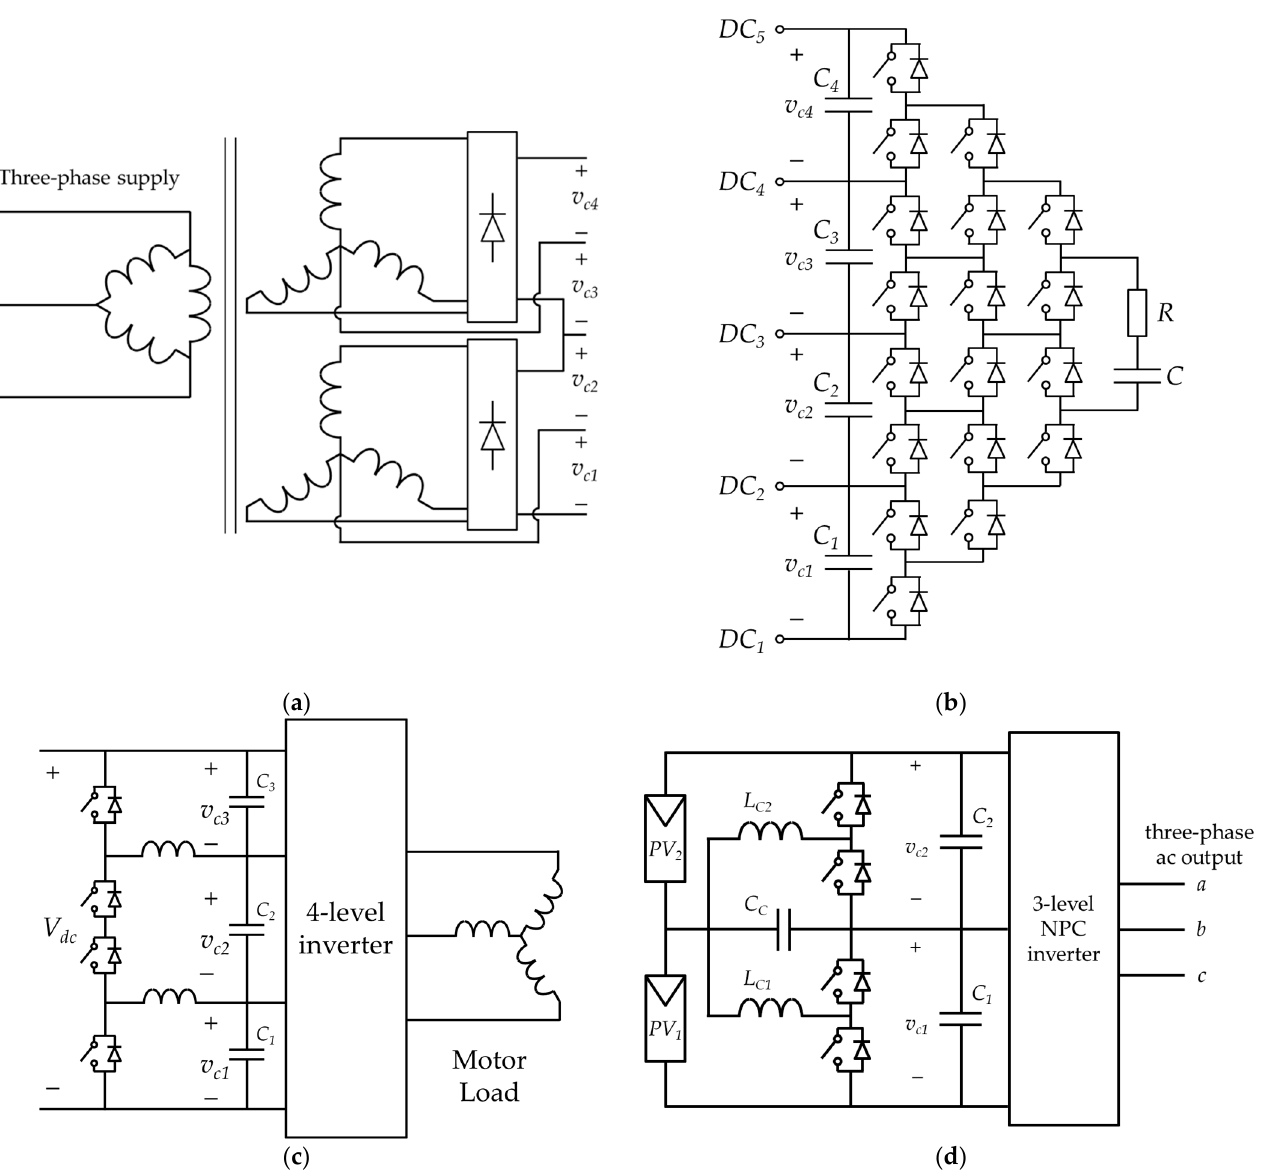
Figure 16. Circuits for balancing with hardware methods: ( a ) Separated DC sources in a 5-level NPC [152]; ( b ) external circuit added to a 5-level NPC as auxiliary voltage balancing circuit [157]; ( c ) 4-level two-quadrant DC–DC converter [158]; ( d ) two-stage configuration. DC–DC converter to balance the DC-link voltages from the unbalanced voltages of the photovoltaic panels [45].